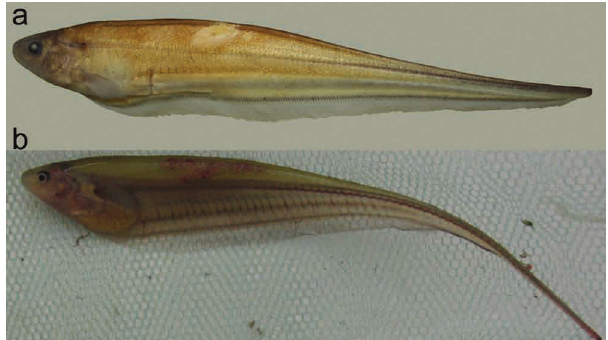
Fig. 3. Left lateral view of fixed specimen (a) and live specimen (b) of Eigenmannia sp. “B”, MPEG